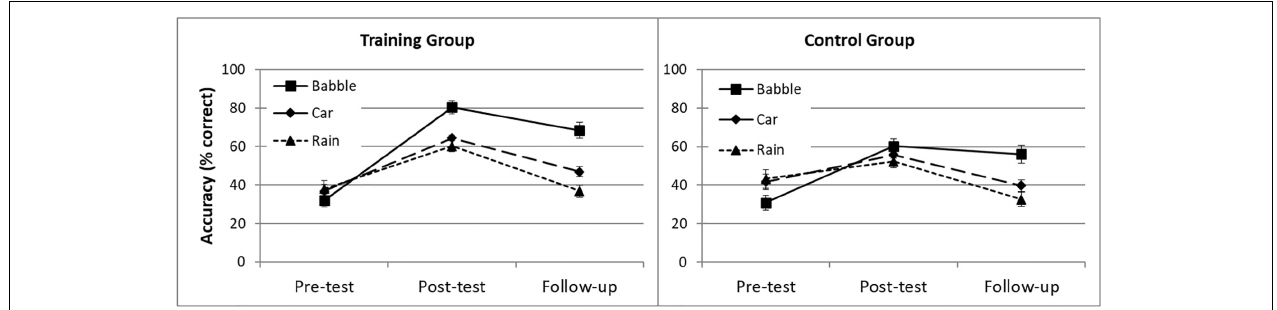
FIGURE 5 | Word identification accuracy for the training ( n = 9) and control group ( n = 7) from three test sessions (pre-test, post-test, and follow-up test) with three different background noises (babble, car and rain noise).